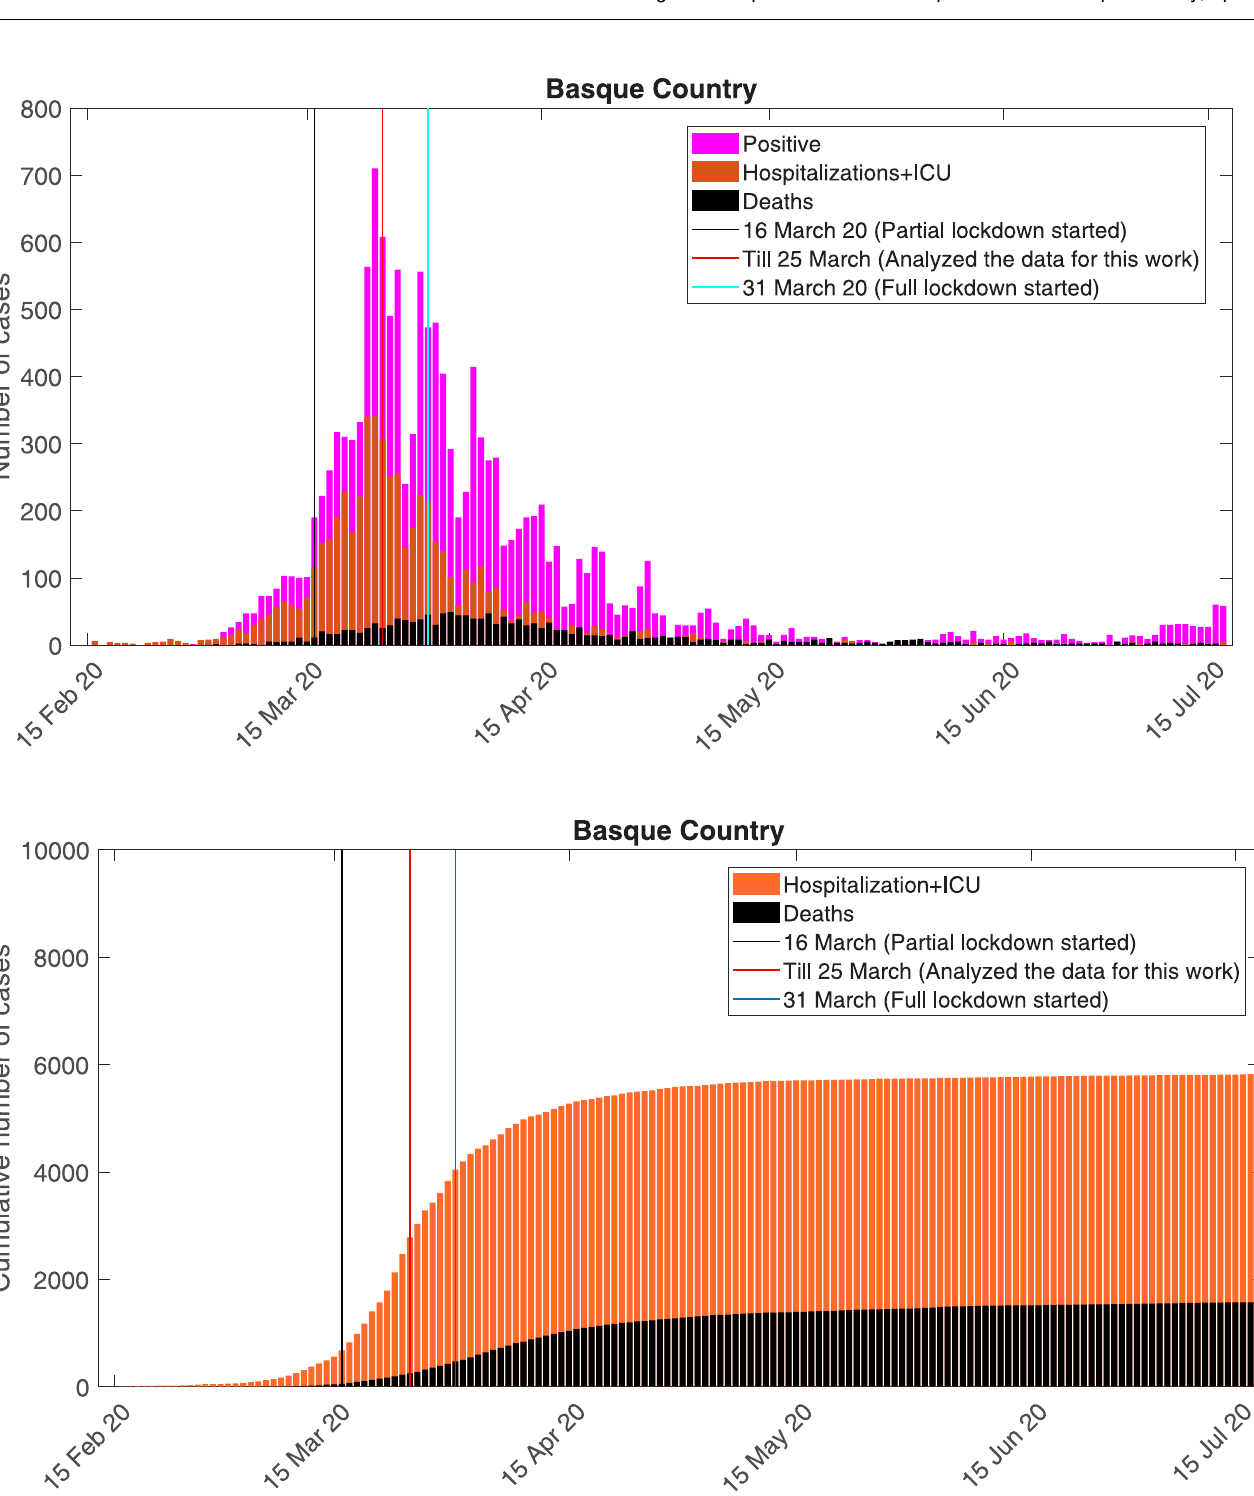
PLOS ONE | https://doi.org/10.1371/journal.pone.0267772 July 13,